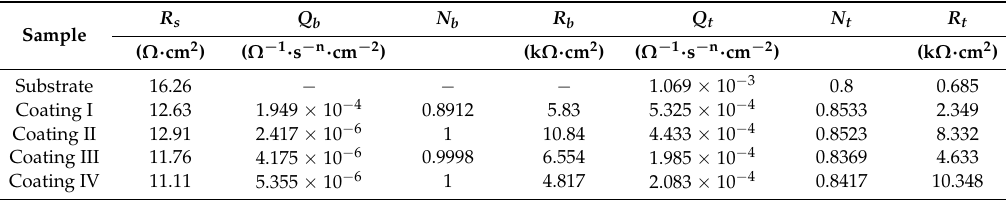
Figure 18. Equivalent circuits of the EIS plots for substrate ( a ) and coating ( b ) in the 5% NaCl solution. Table 4. EIS data of substrate and